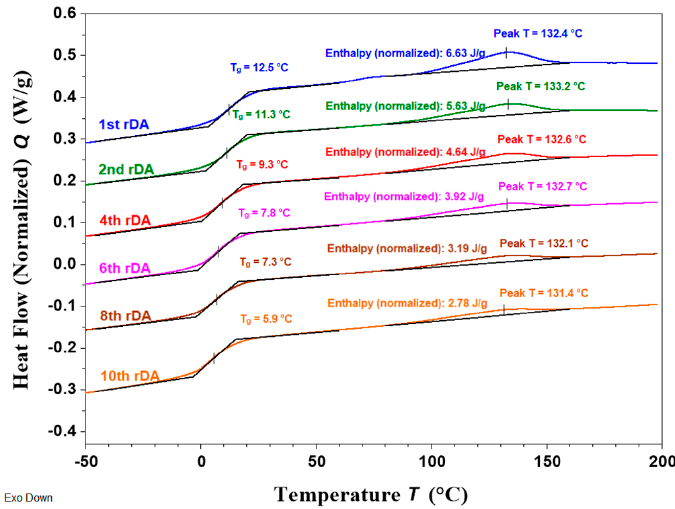
Figure 10. DSC consecutive heating scans at 10 °C/min for the sample PURSF-07 (9%TB).